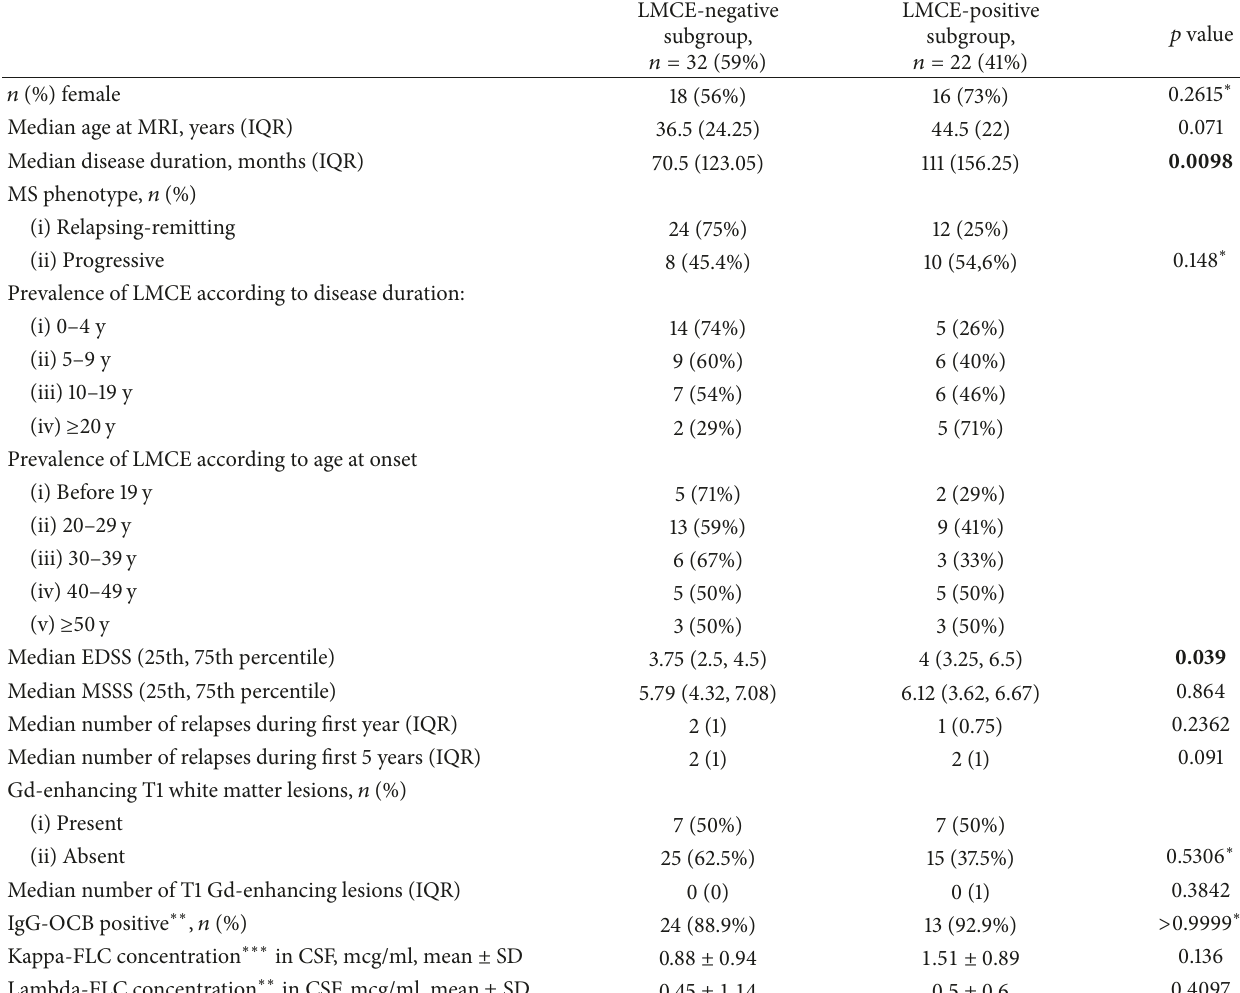
Table 2: Characteristics of leptomeningeal enhancement in the total